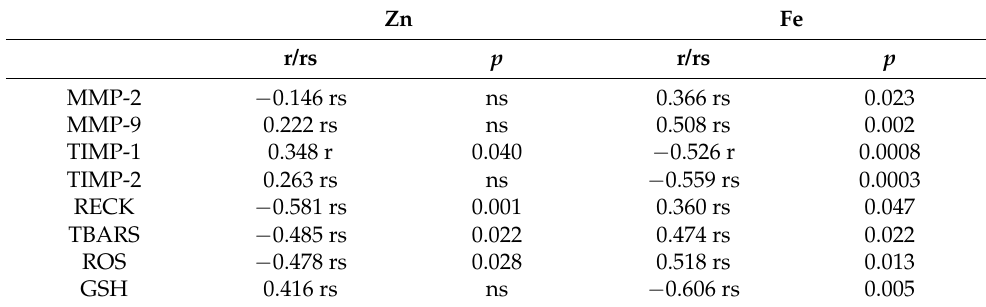
Table 3. Correlation between liver Zn and Fe versus MMPs, TIMPs, RECK, TBARS, ROS and GSH. Zn Fe r/rs p r/rs p MMP-2 − 0.146 rs ns 0.366 rs 0.222 rs 0.348 r − 0.581 rs